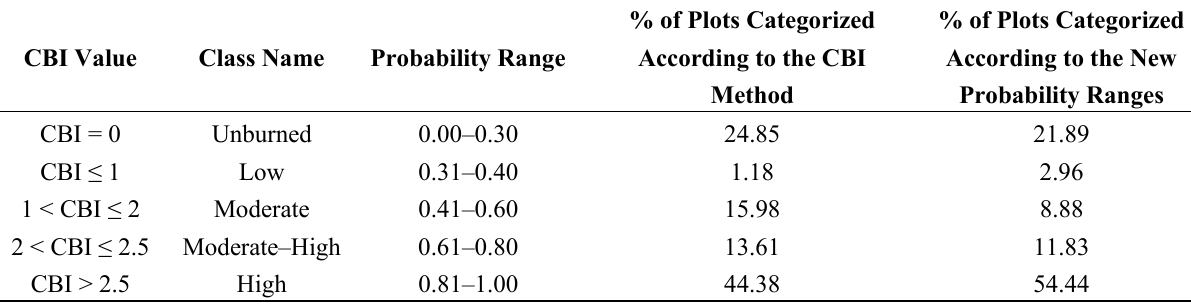
Table 11. The classification system used to produce fire severity categories and the proportions of plots by category.